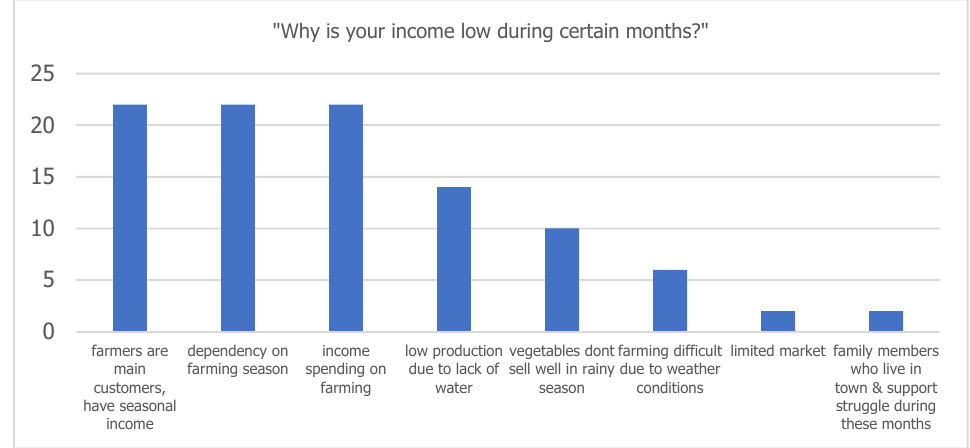
Figure A1. Income intermittency in Uganda and Zambia (N = 1016; Responses in %; Multiple re- sponses possible).